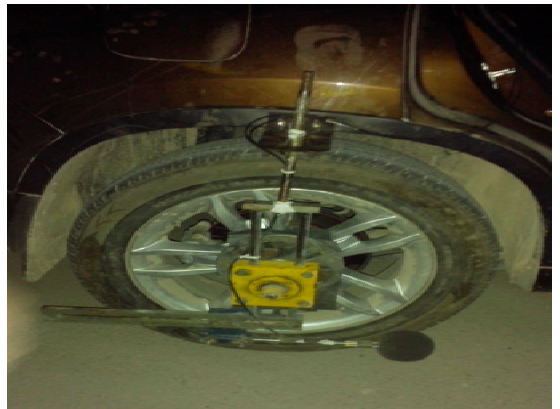
Figure 2. The on-board sound intensity system (OBSI).